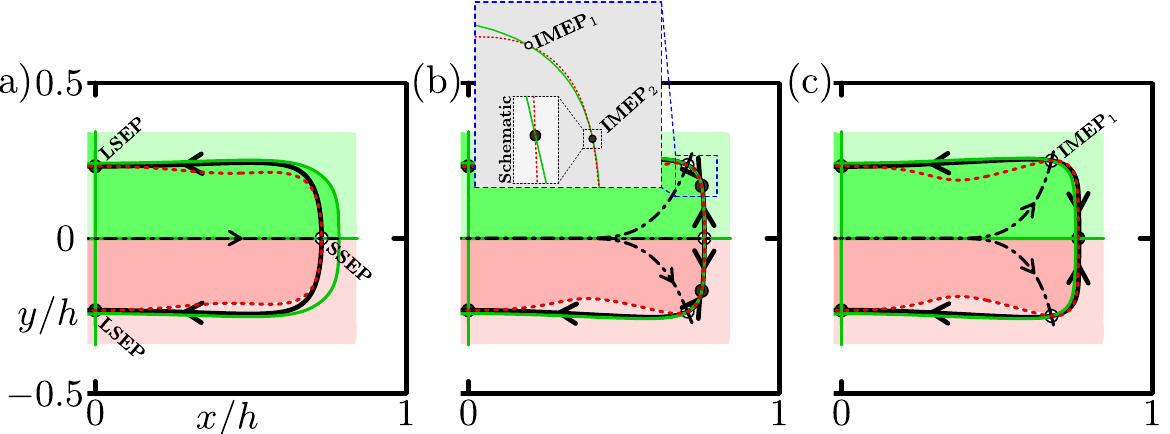
Figure 7. Nullclines of the lateral trajectories of a suspended particle. The red dashed curves represent the r -nullcline. The green solid curves and lines aligned with the axes are the θ -nullcline. Filled and open circles correspond to stable and saddle equilibrium points, respectively. Equilibrium points in ( a ) are the long side equilibrium point (LSEP) and the short side equilibrium point (SSEP), those in ( b ) are the LSEP, the SSEP, and two types of the intermediate equilibrium point (IMEP 1 and IMEP 2 ), and those in ( c ) are the LSEP, the SSEP, and the IMEP 1 . A = 2, d / h = 0.3125. ( a ) Re = 100, ( b ) Re = 255, ( c ) Re = 300.